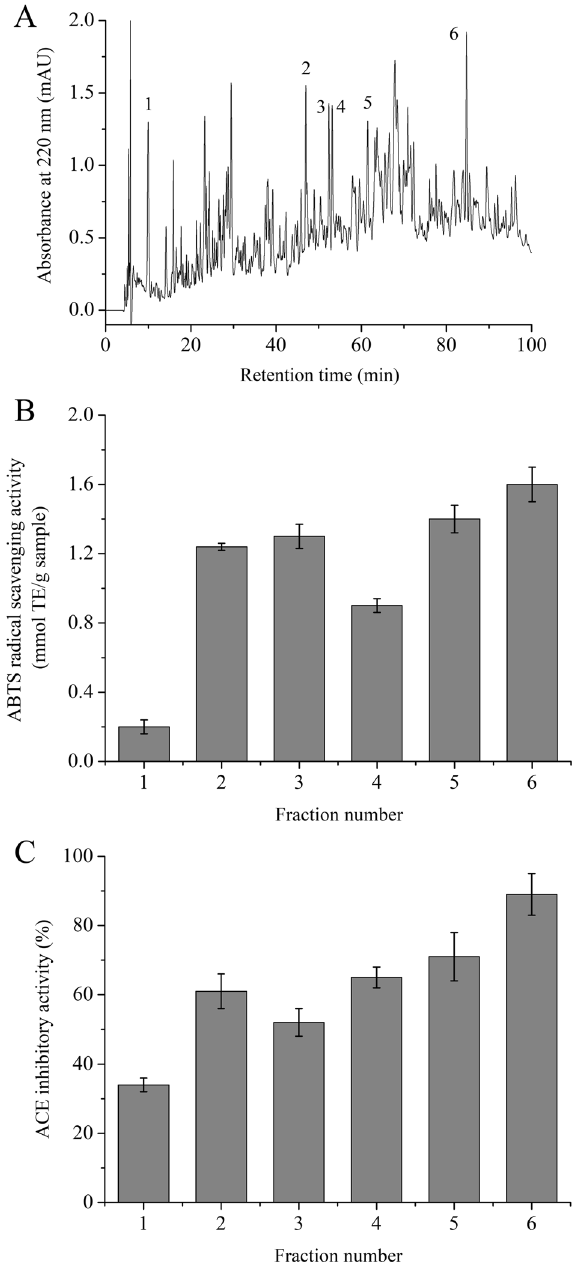
Figure 3. ( A ) Elution profile of WOP separated by RP-HPLC on an XBridge BEH130 C18 column (4.6 mm × 250 mm) at a flow rate of 0.6 mL/min with a linear gradient of solvent A (0.1% TFA in Milli-Q water, v/v) and solvent B (80% acetonitrile with 0.1% TFA, v/v). Six fractions were collected and designated fractions 1–6. ( B ) ABTS free radical scavenging activity of the collected fractions from the RP-HPLC system. The results are expressed as mmol Trolox equivalent (TE)/g sample. ( C ) ACE inhibitory activity of the collected fractions from the RP-HPLC system at a concentration of 0.7 mg/mL. Error bars indicate the standard deviation (n =